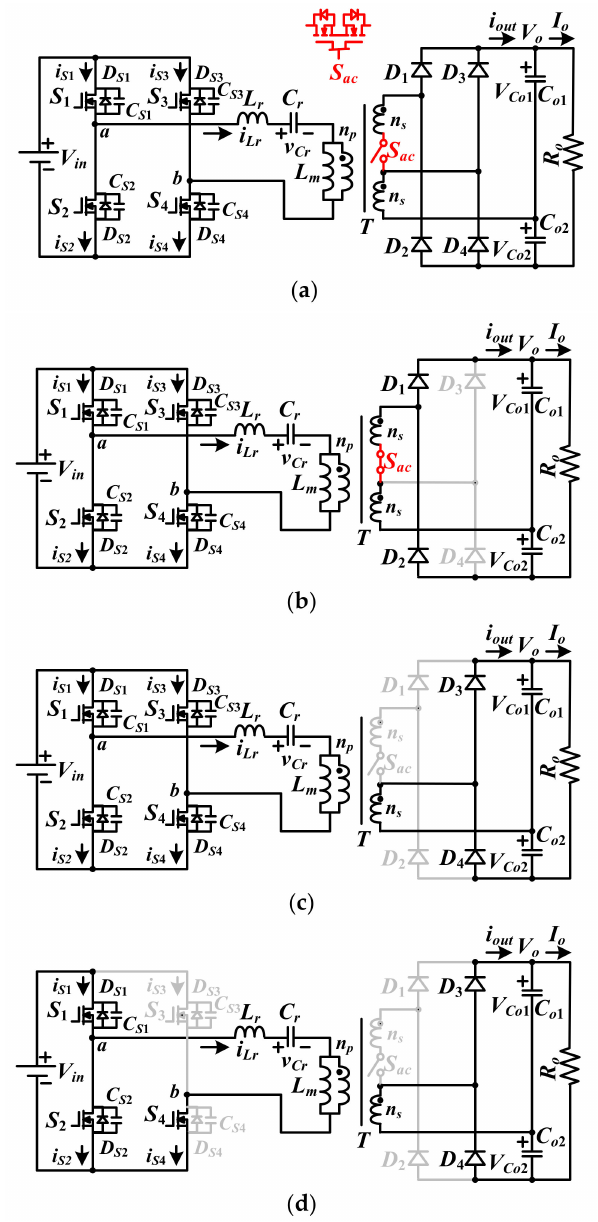
Figure 2. Proposed converter: ( a ) circuit diagram; ( b ) low input voltage region; ( c ) medium input voltage region; ( d ) high input voltage